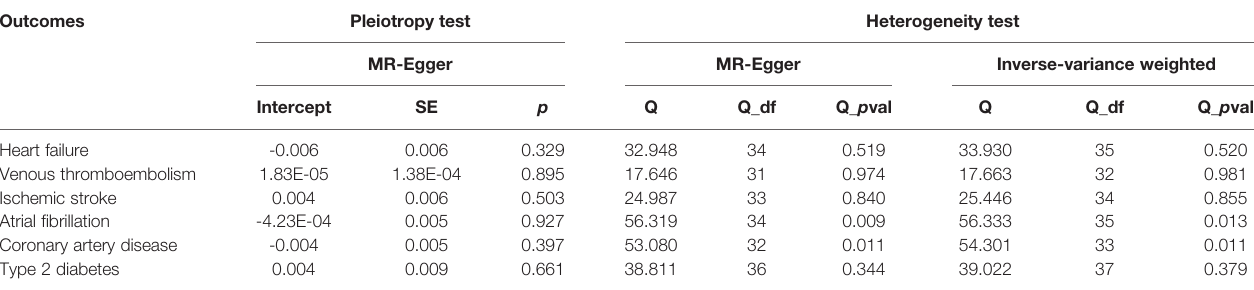
TABLE 2 | Pleiotropy and heterogeneity test of the SLE IVs from CVD GWAS.